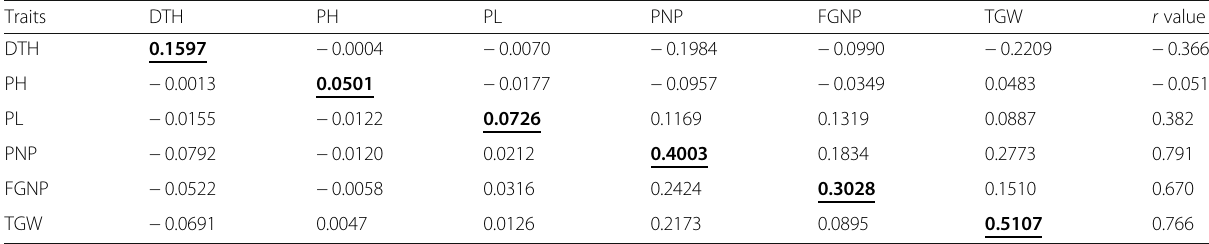
Table 3 Path coefficient analysis among grain yield and its components of 22 Egyptian and exotic rice genotypes Traits